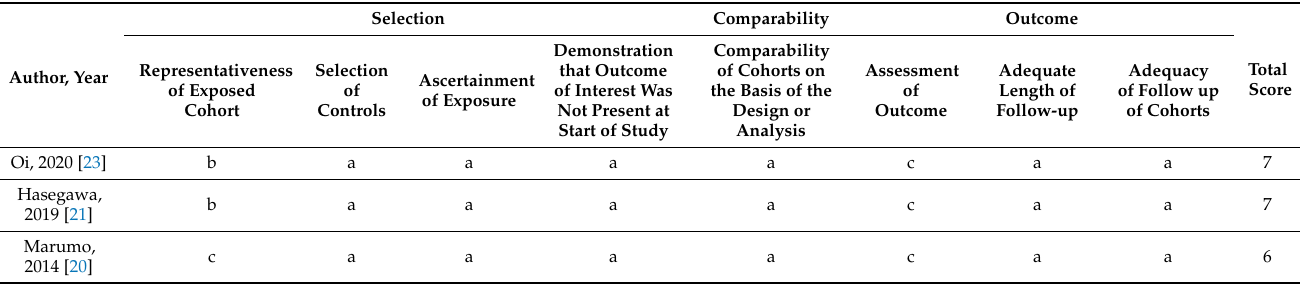
Table 3. Risk of bias assessment, Newcastle–Ottawa Scale.